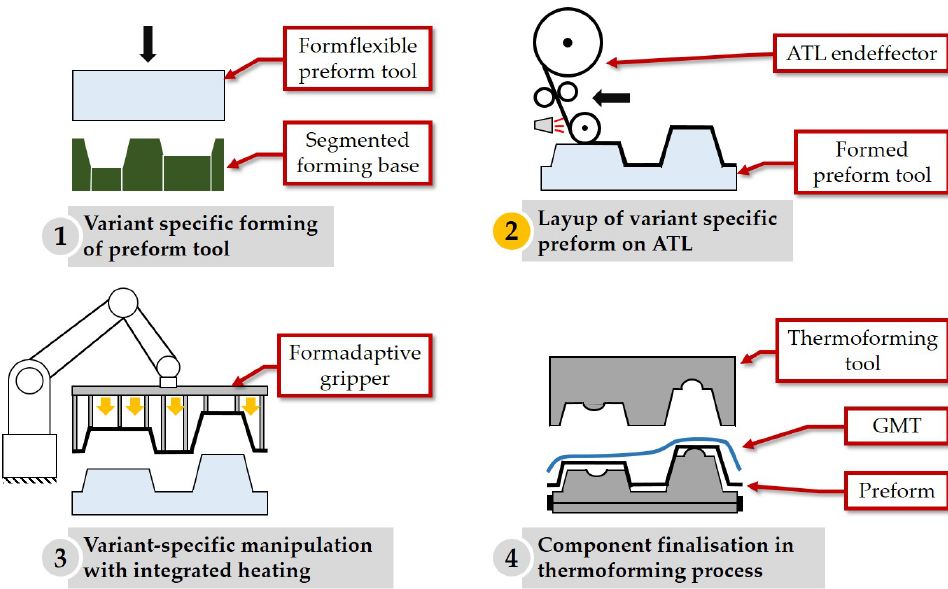
Figure 1. Process chain for the production of variant-flexible lightweight components based on fiber–plastic–metal